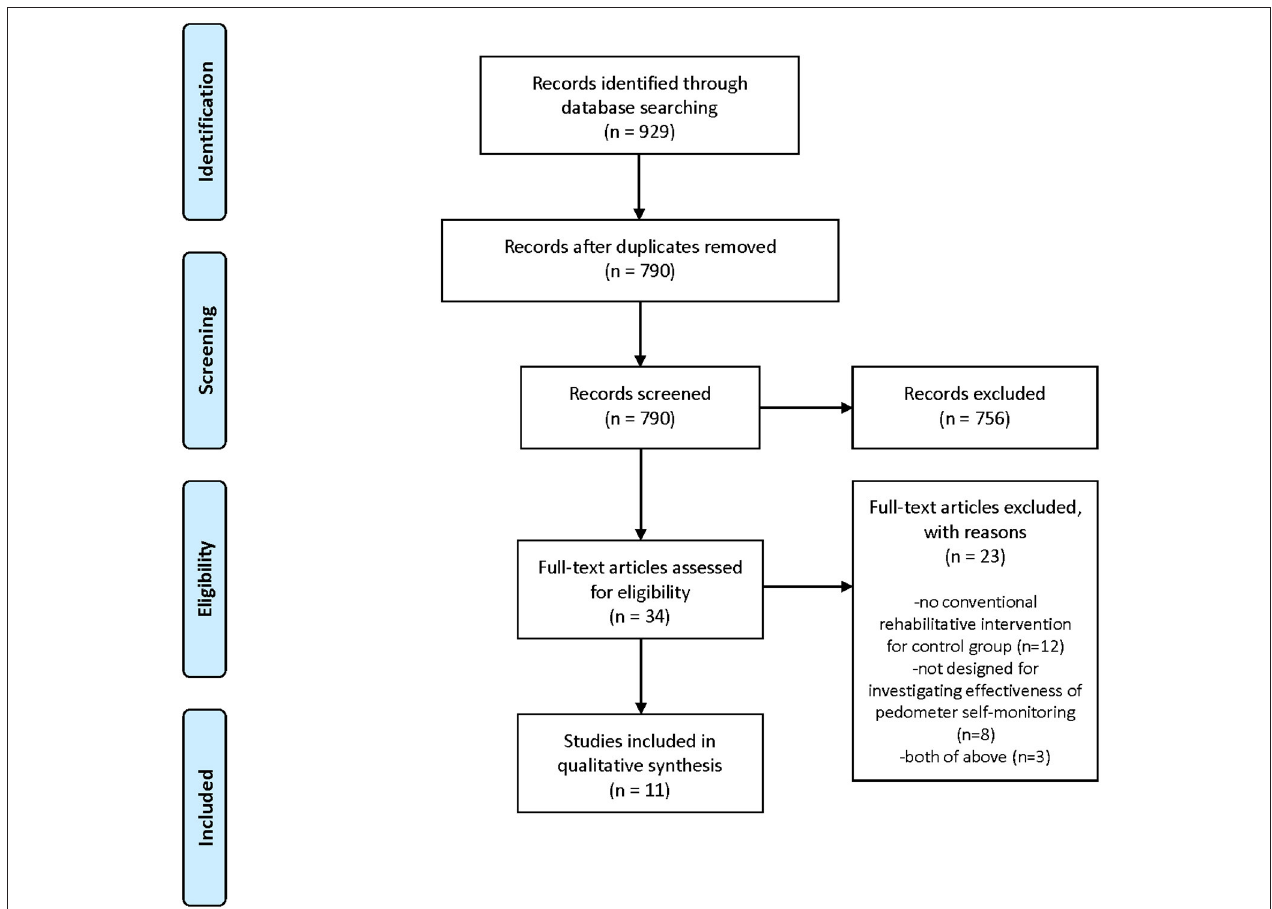
FIGURE 1 | PRISMA flow diagram of the literature search and study